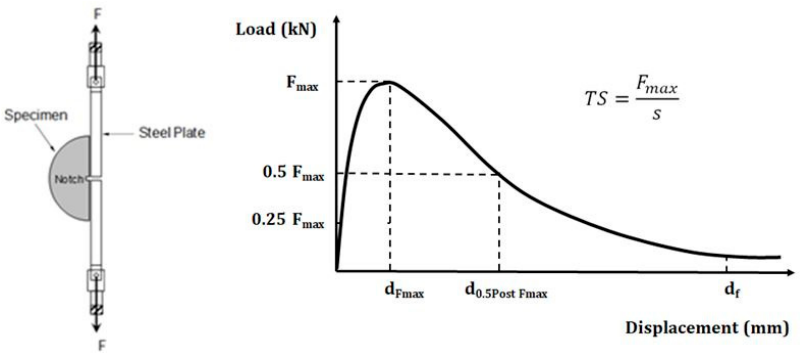
Figure 1. Fénix test set ‐ up and stress–displacement output curve. Figure 1. F é nix test set-up and stress–displacement output